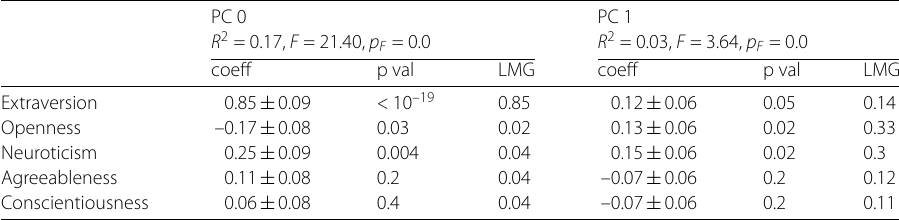
Table 9 Extraversion, openness, and neuroticism explain socio-spatial behaviour. The result of a multiple linear regression explaining principal components of socio-spatial data (see Table 7). The value of each coefficient (coeff) is reported together with the probability (p val) that the coefficient is not relevant for the model. The relative importance of each coefficient (LMG) is computed using the LMG method